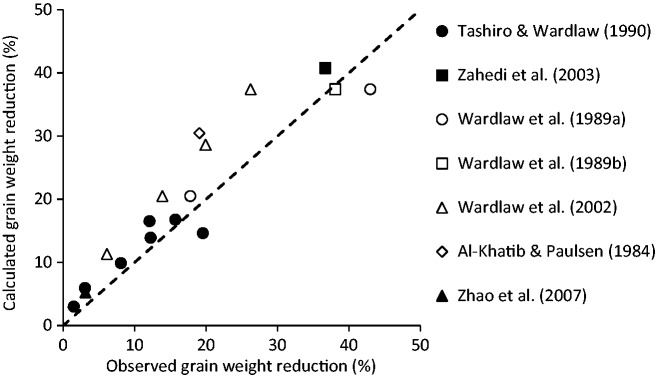
Observed values vs. calculated values for the reduction in final grain weight between temperatures treatments. Observed data come from the literature [see Supporting Information—Table S1]. Dashed line is the model x = y.